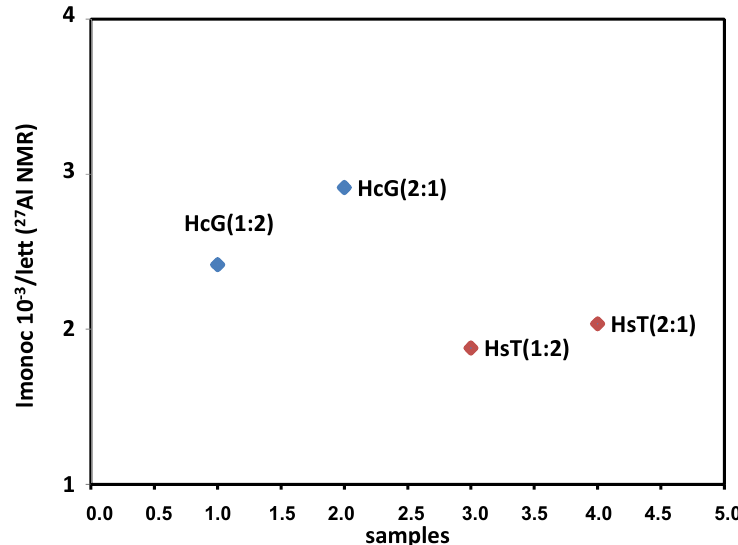
Figure 7. Ratio of the intensities of the 27 Al NMR signals for monocarboaluminate and ettringite (8/13.4).